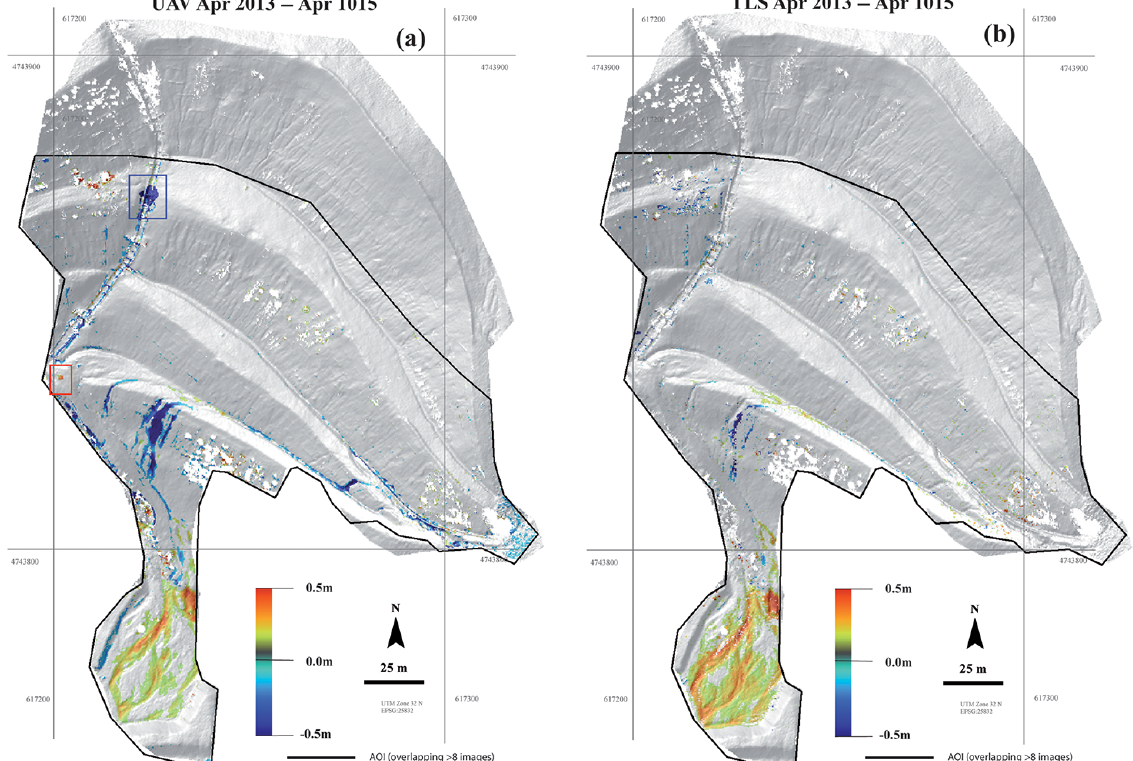
Figure 12. Comparison of the surface changes of the 2013 to 2015 epoch for (a) the UAV data (for an explanation of the two squared areas see Fig. 8) and (b) the TLS